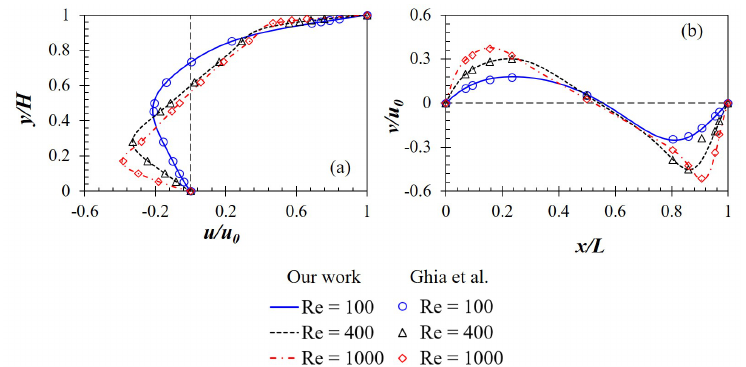
Figure 7. ( a ) x -velocity along the vertical centerline and ( b ) y -velocity along the horizontal centerline produced by a Newtonian fluid in a square cavity at Re = 100, 400 and 1000.